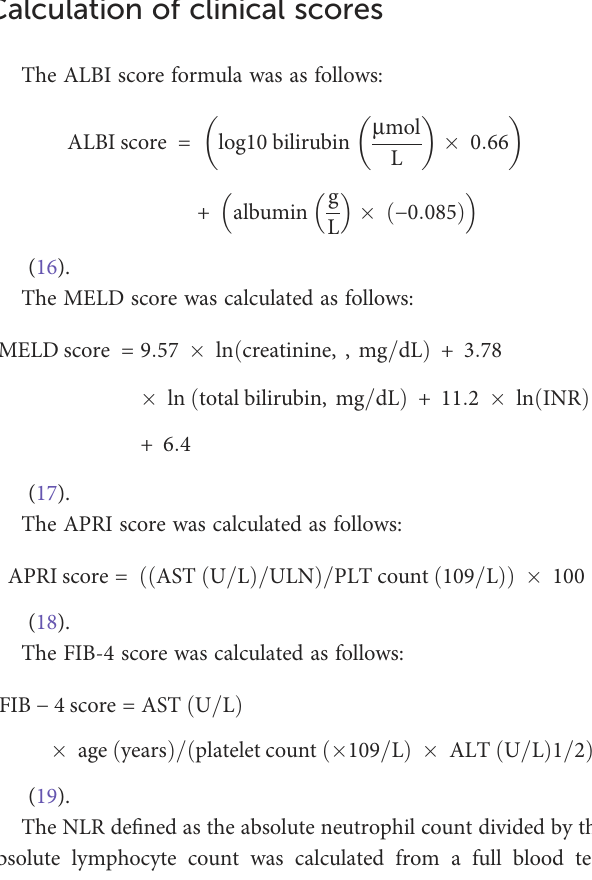
FIGURE 2 Flow chart for patient